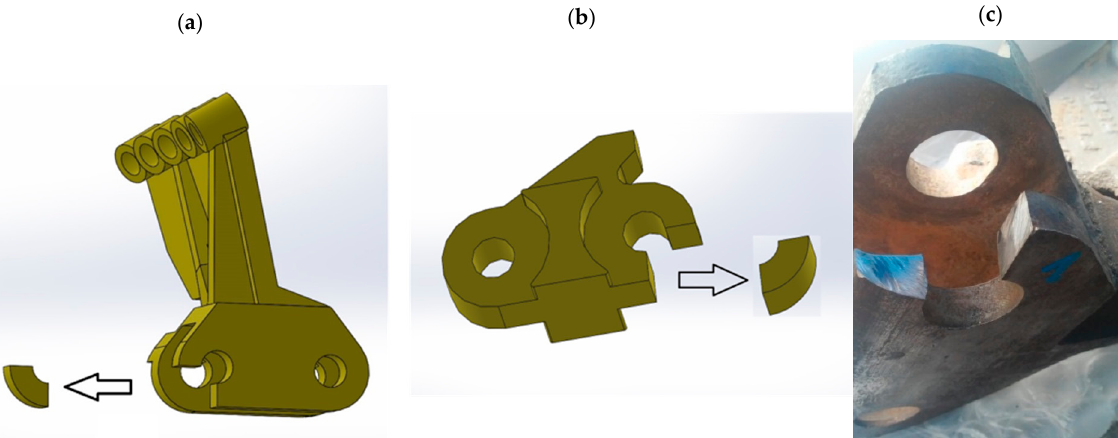
Figure 5. Method of taking samples for testing: ( a ) the scraper shovels, ( b ) the chain connector, ( c ) the photograph of exemplary real-world sample source.